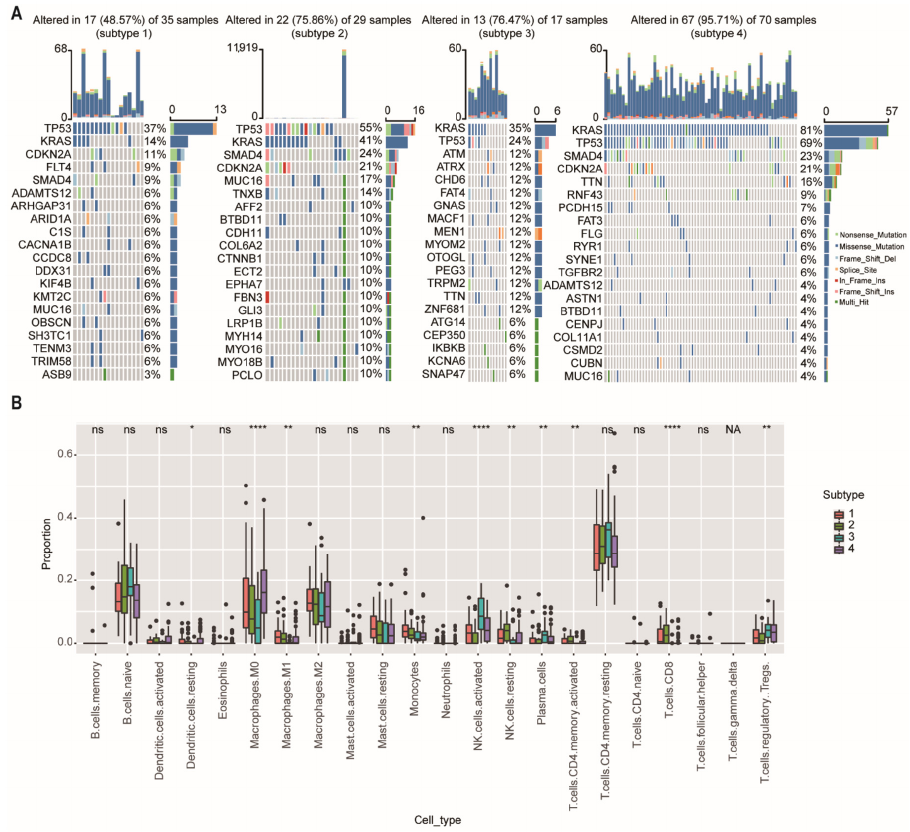
Figure 6. Somatic mutations and immune cell infiltration among the network-based subtypes. ( A ) The distribution of gene mutations among network-based subtypes. KRAS and TP53 were the top 2